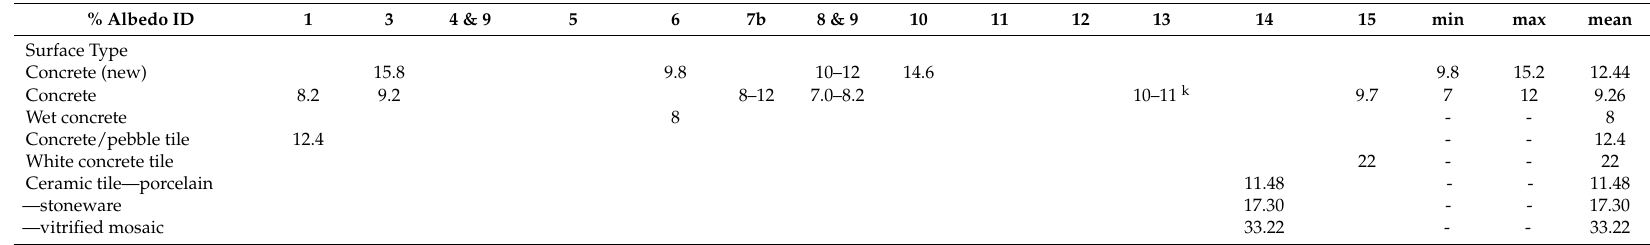
Table 4. Broadband UV albedo measurements of mostly man-made surfaces in percentages as reported in the literature (Table 2). ID numbers in the top row correspond to the ID numbers assigned in Table